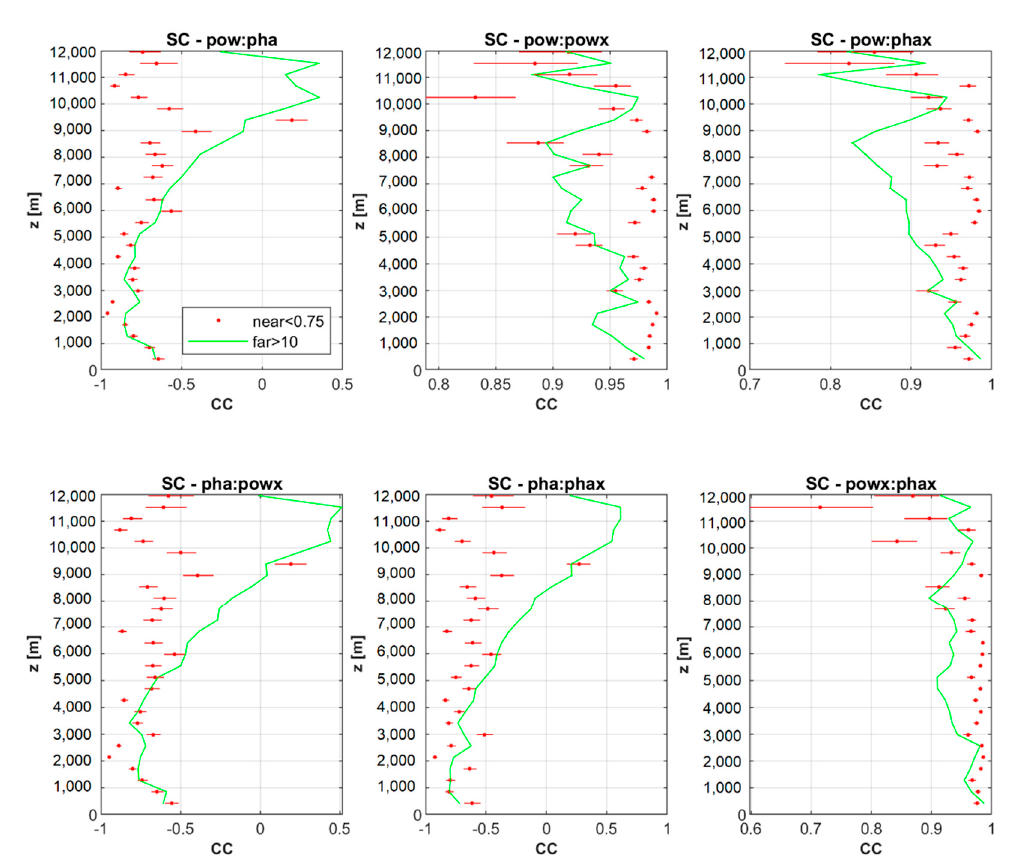
Figure 12. Correlations (CC) by Spearman (SC) between pairs of pow, pha, powx and phax in dependence on height (z [m]) above the radar site. Red points represent SC for “near(0.75 km)” data, while the green line indicates SC for “far” data. Horizontal lines shows 95% confidence intervals.